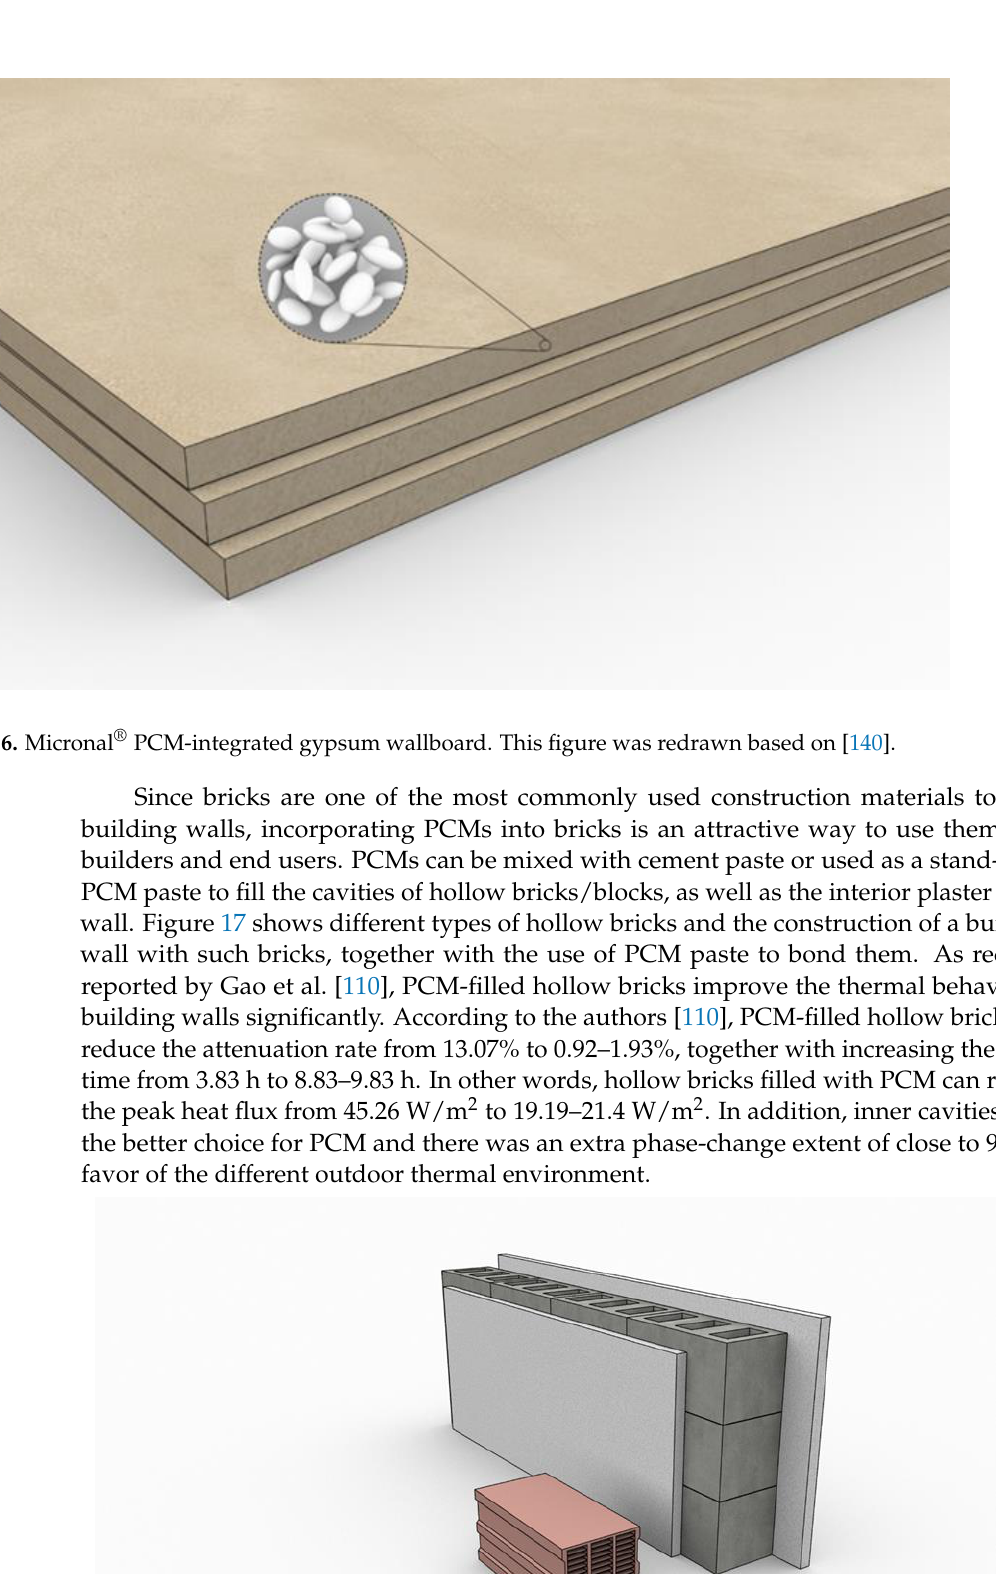
Figure 18. PCM usage as interior plaster on hollow building blocks. A comparison of common wall-building materials in terms of their respective heat storage capacities is shown in Figure 19. The heat storage capacity of PCMs far exceeds